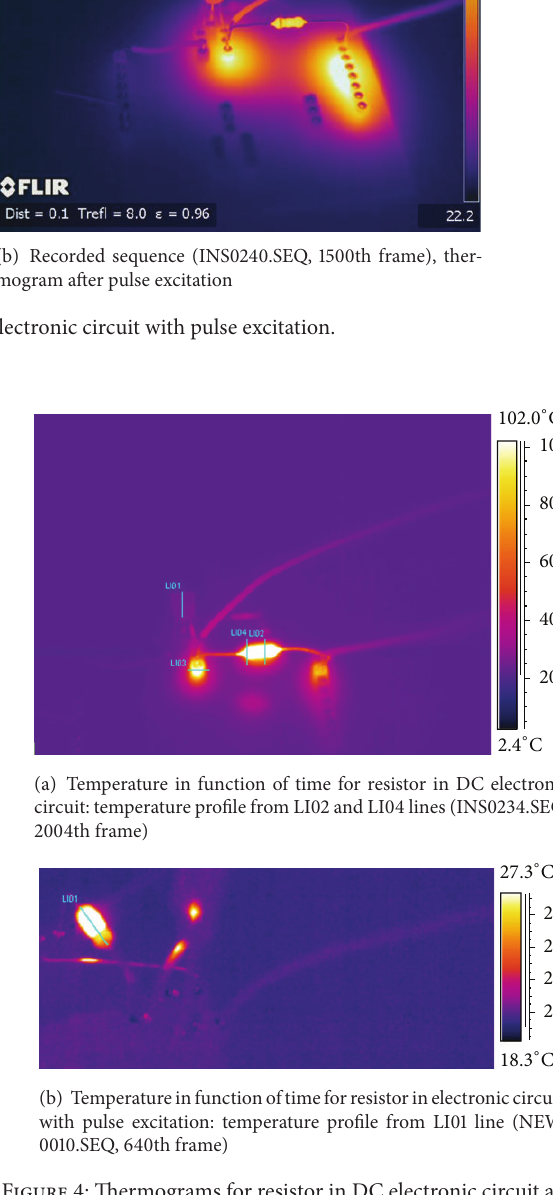
Figure 4: Thermograms for resistor in DC electronic circuit and in electronic circuit with pulse